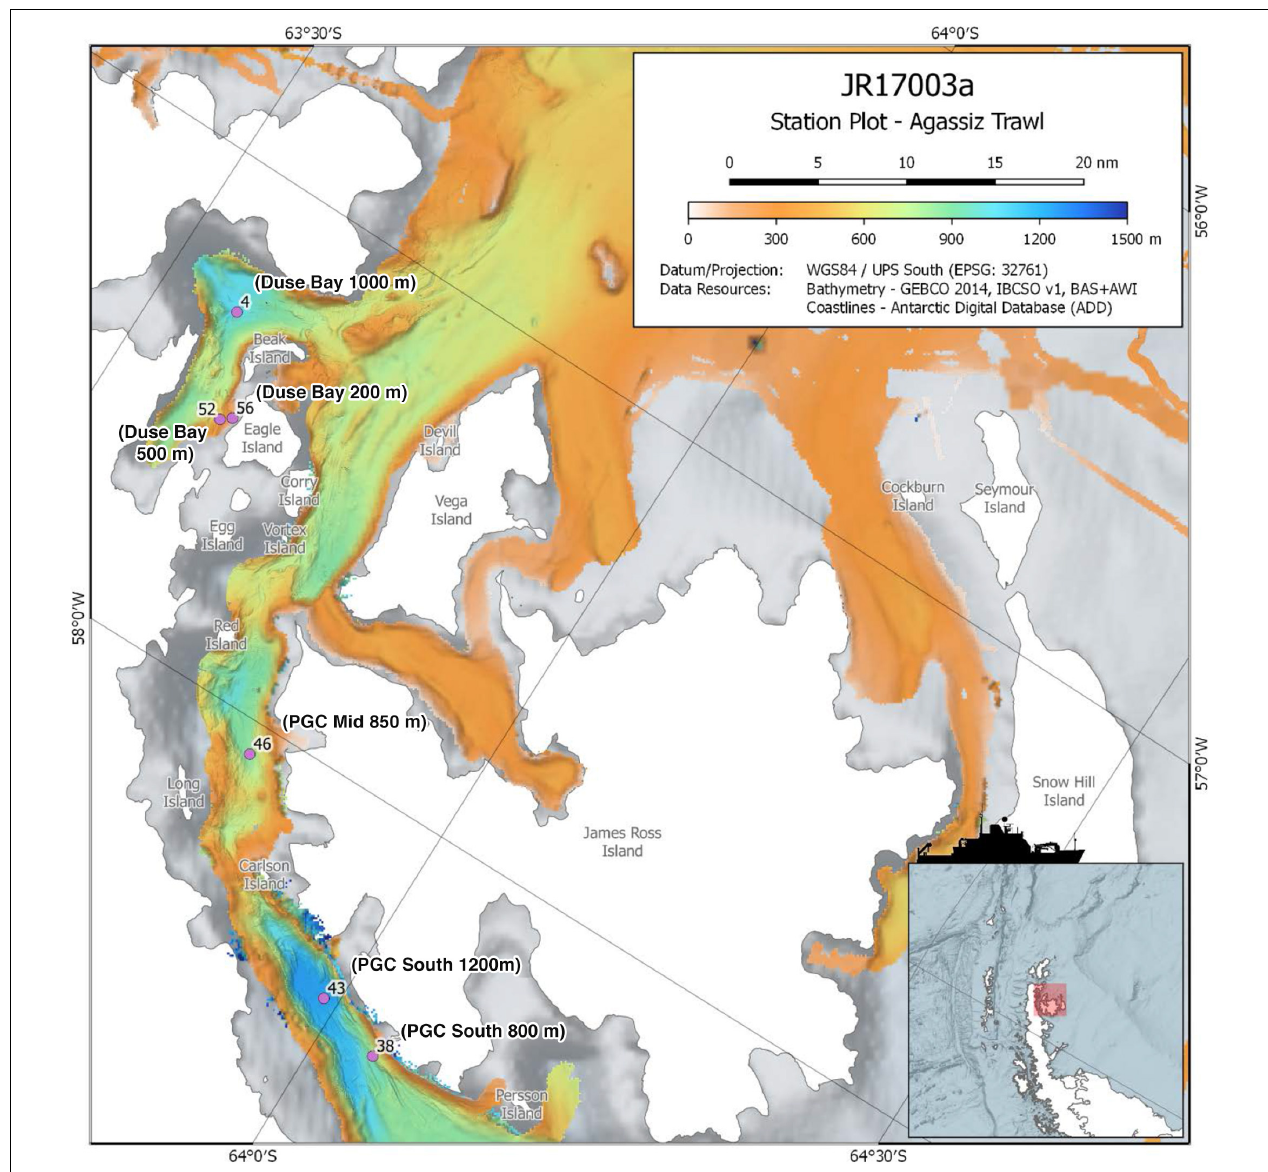
FIGURE 1 | Map of study area within the Prince Gustav Channel, showing the six Agassiz trawl sites, marked with event number and sample name. Modified from RRS James Clark Ross expedition JR17003a cruise report, accessible via https://www.bodc.ac.uk/resources/inventories/cruise_inventory/report/16954/. See Dreutter et al. (2020) for archived bathymetry data from the JR17003a